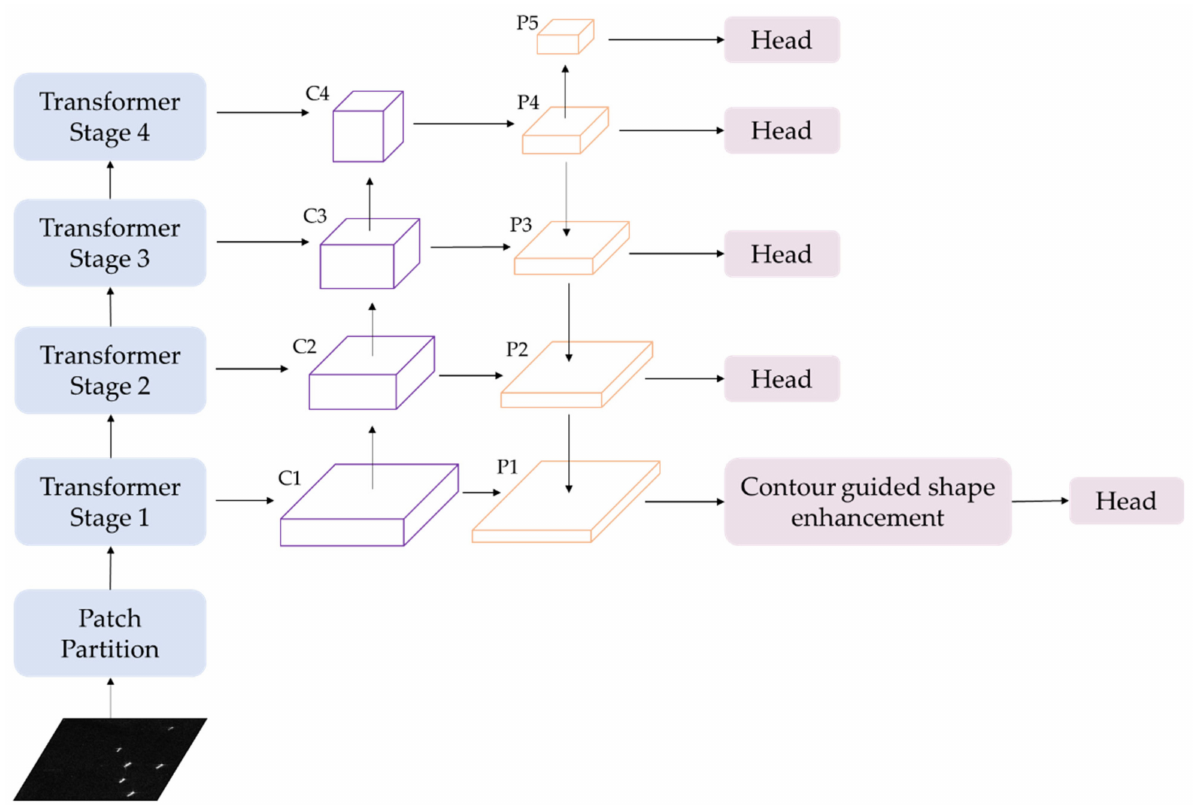
Figure 1. Overall framework of proposed